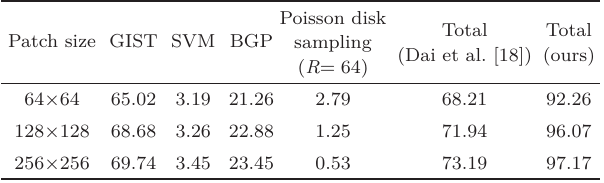
Table 1 Time (in ms) for our method and that of Dai et al., for 800 × 600